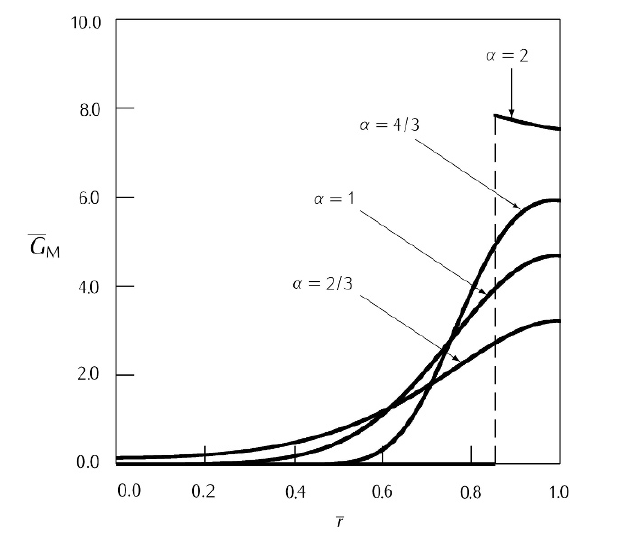
on the radial coordinate for H = 0 . 2 , κ = 0 . 15 M